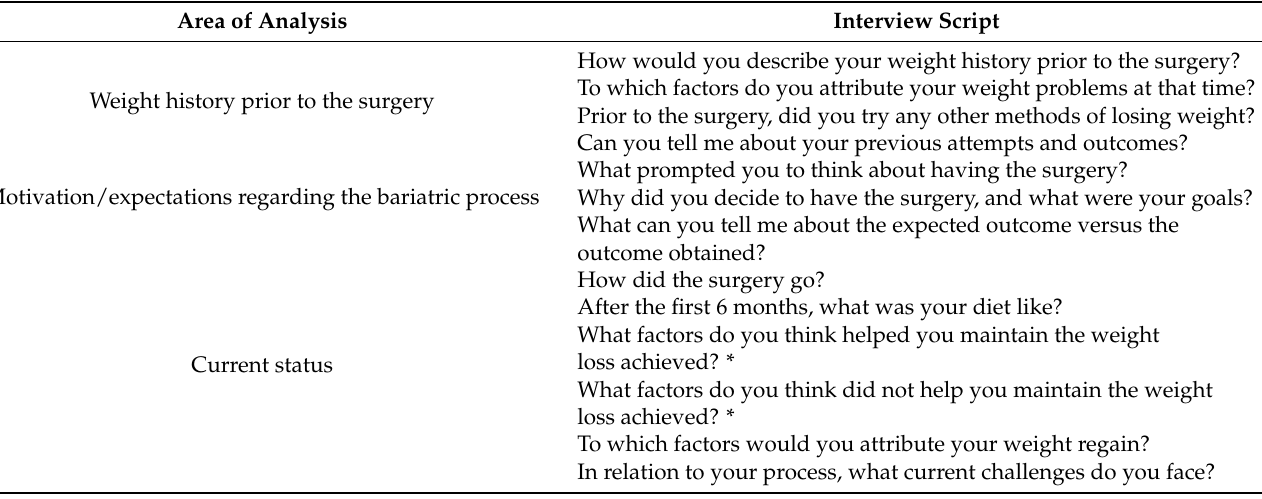
Table 1. Interview script and areas of